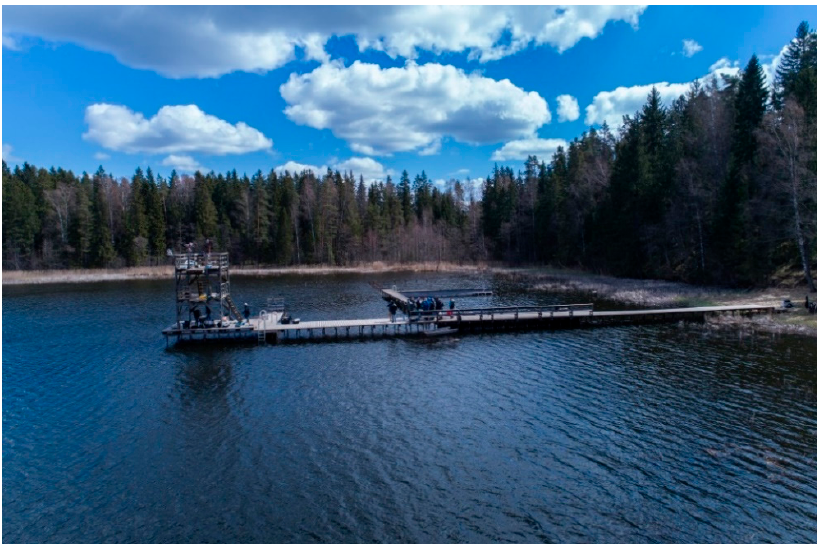
Figure 2. Pier and diving platform at the southern coast of Lake Kääriku.